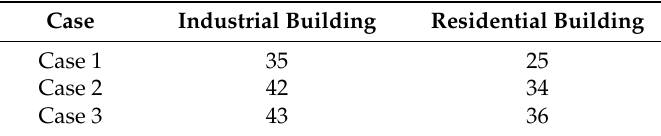
Table 3. Buildings selected for the di ff erent cases.